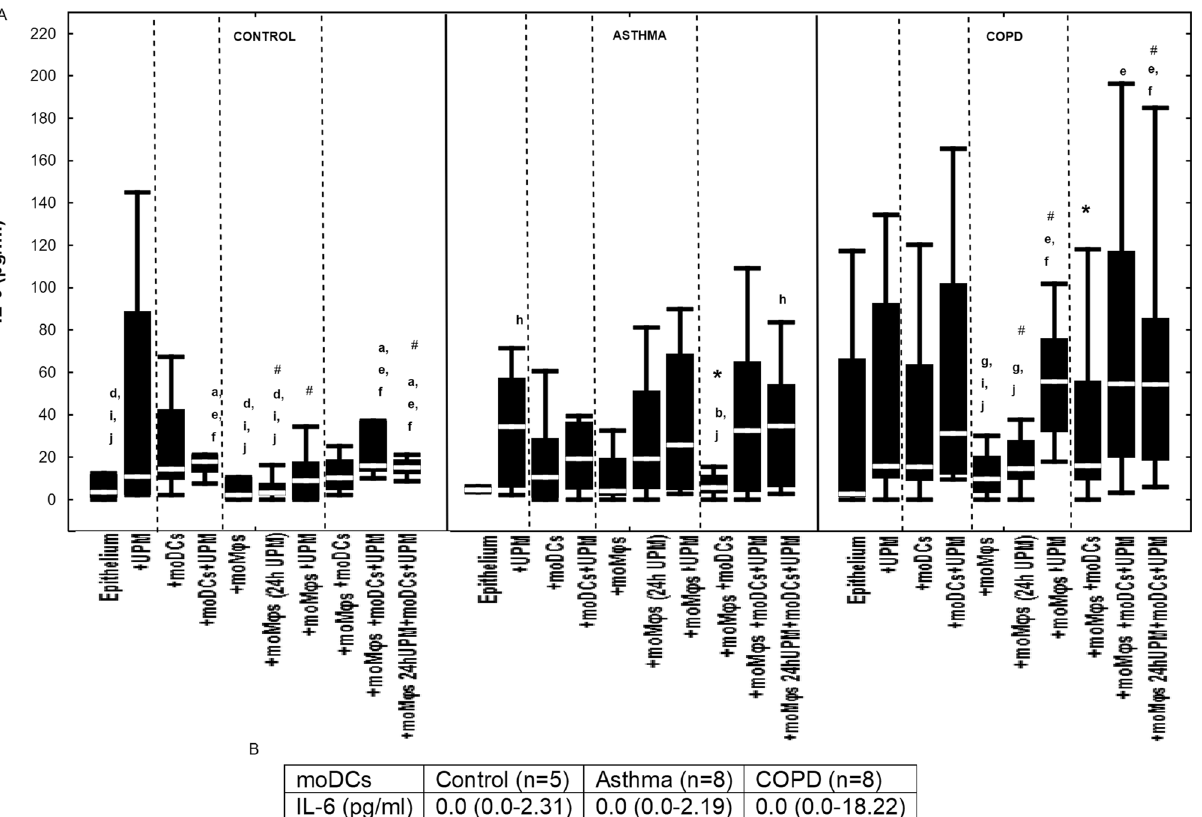
Figure 10. ( A ) IL-6 secretion by air–liquid interface (ALI) cultured nasal epithelium after 24 h UPM exposure in multi co-culture schemes in control subjects, asthma and COPD patients. ( B ) IL-6 levels produced by moDCs cultured alone are shown in table. The data are shown as non-outlier range (whiskers), interquartile range (box) and median (line); p value calculated using Mann–Whitney U test. The p value < 0.05